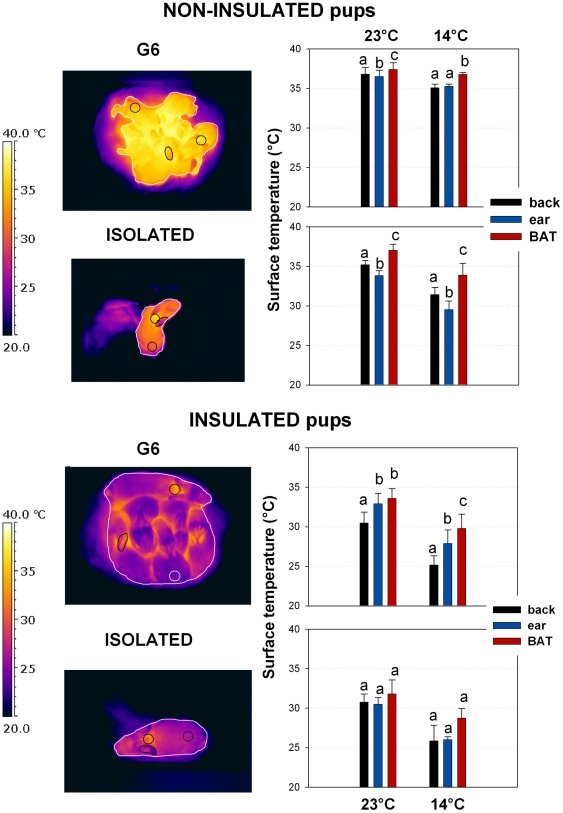
Surface temperature of back, ear and brown adipose tissue (BAT) of isolated (G1) and huddling (G6) pups, non-insulated and insulated, exposed at 23°C and 14°C.The results of post-hoc Tukey tests are shown by the letters a to c: same letter showed no significant difference. Left panel: Thermal images are shown for isolated (G1) and huddling (G6) non-insulated and insulated pups, exposed to an ambient temperature of 14°C. Images show the location of circles used to compare surface temperature (total area, back, ear, brown adipose tissue (BAT)).